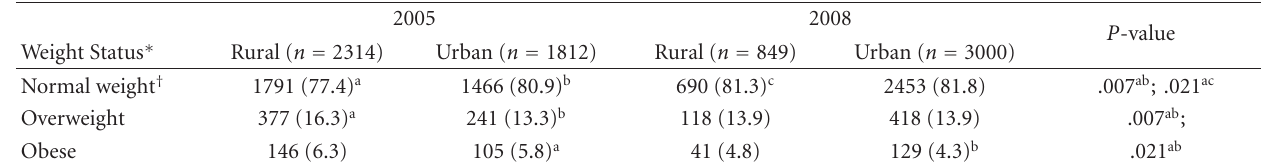
Table 3: The weight status of rural and urban students in 2005 and